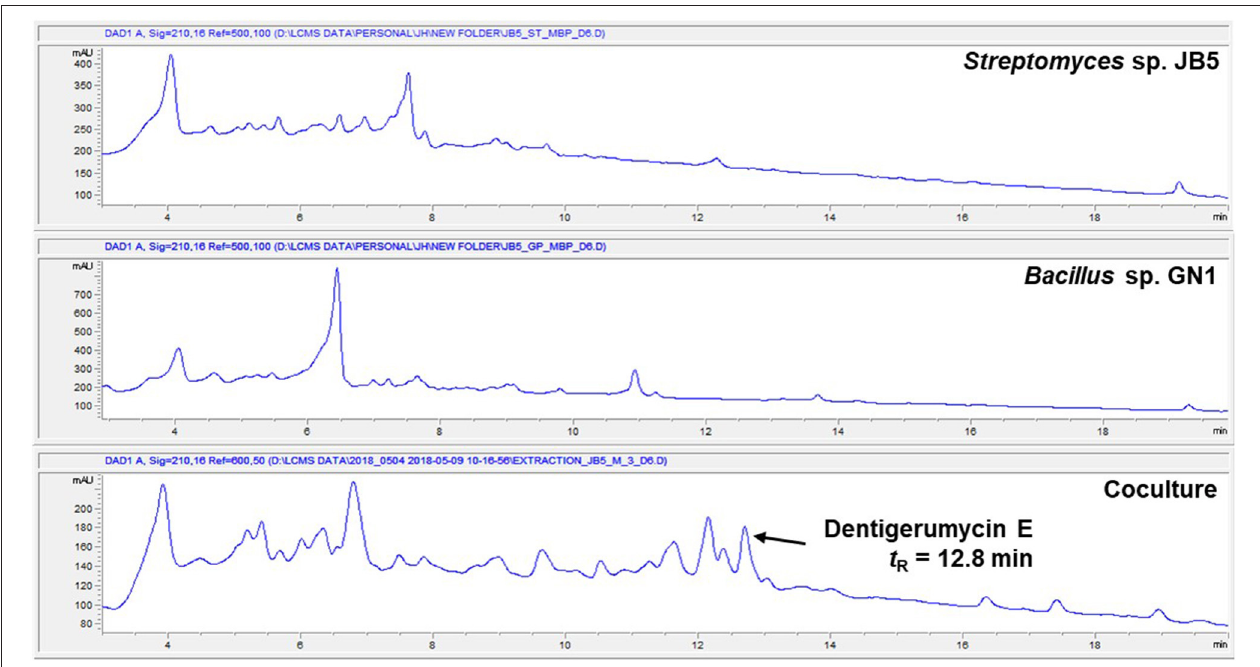
FIGURE 1 | HPLC profiles of the single culture of Streptomyces sp. JB5, the single culture of Bacillus sp. GN1, and their coculture.